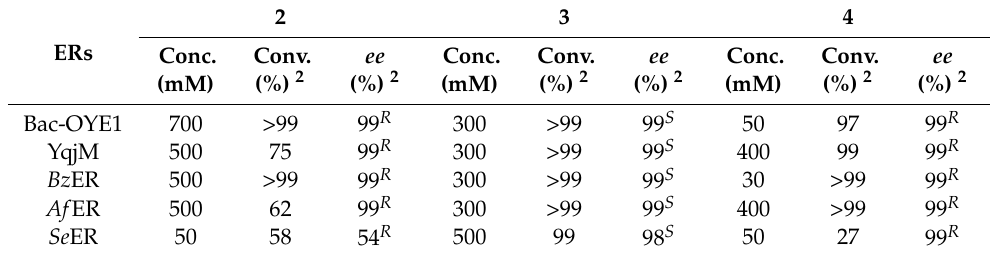
Table 1. Asymmetric reduction of 2 , 3 and 4 catalyzed by 5 ERs 1 .